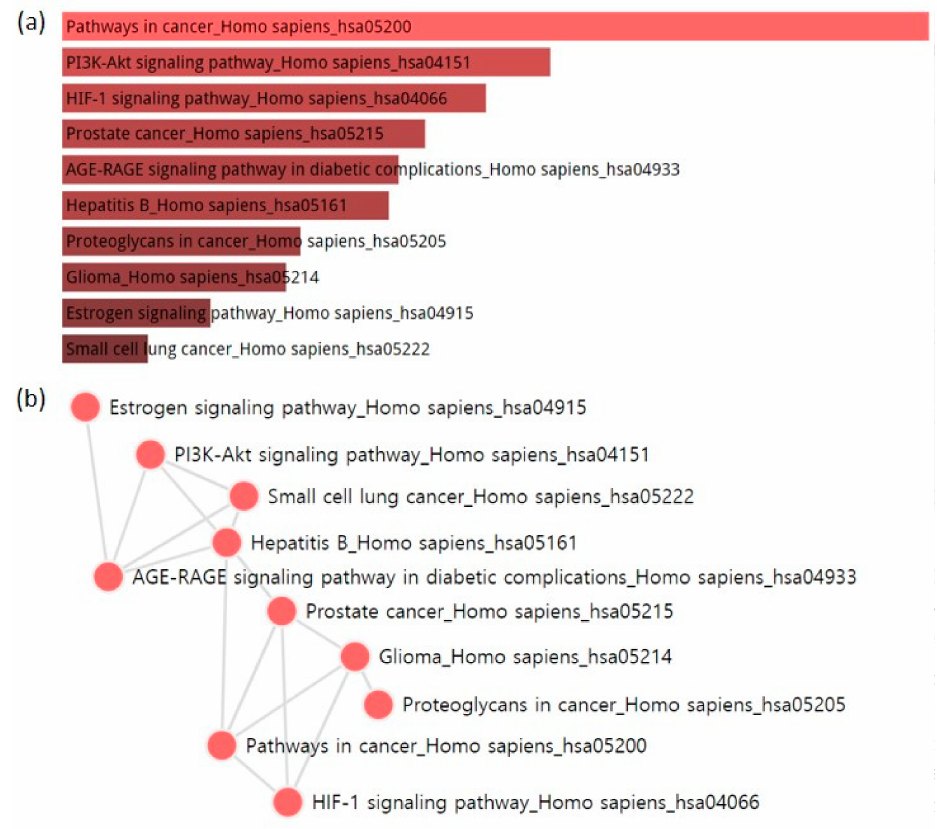
Figure 5. Pathway analysis using the Kyoto Encyclopedia of Genes and Genomes (KEGG) 2016 library. Analysis was performed on the “Enrichr” platform (http://amp.pharm.mssm.edu/Enrichr/). The 112 targets of PG were used to obtain the results. ( a ) The top 10 enriched pathway terms are displayed in a bar graph. They are ranked by a combined score calculated by p -value and z -score. The length of the bar and the brightness of its color represent the significance of the specific pathway. ( b ) The top 10 enriched pathway terms are displayed as a network. Each node represents a pathway, and each edge represents the gene content similarity among the